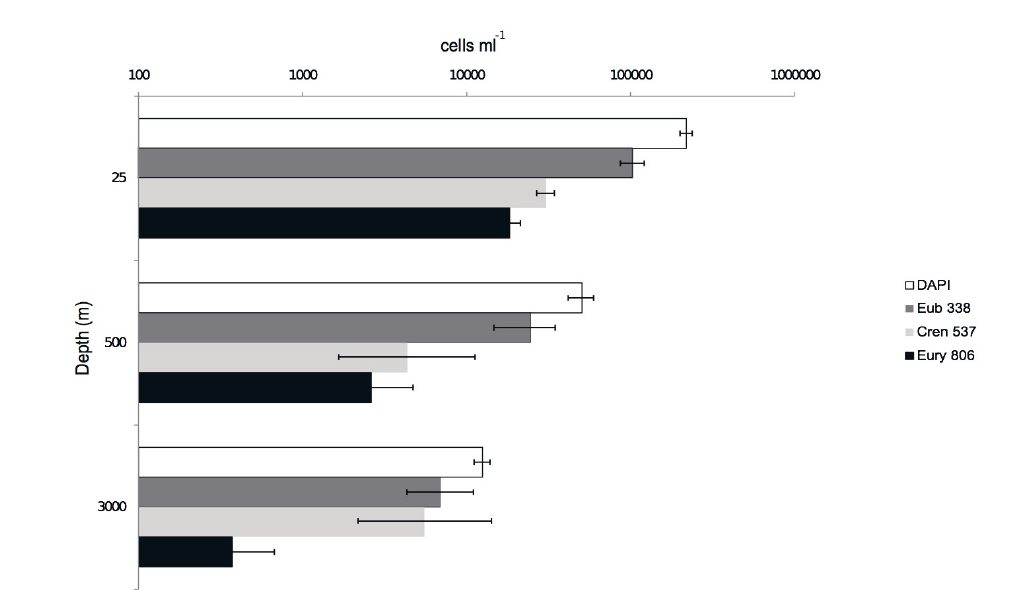
Figure 1. Distribution of total amount of prokaryotic cells counted as DAPI-stained cells (in white), CARD-FISH-positive Bacteria (in dark grey), Crenarchaea (in light grey) and Euryarchaea (in black) at the Station Vector site in December 2013, for 25 m (Modified Atlantic Water (MAW)), 500 m (Levantine Intermediate Water (LIW)) 3000 m (Tyrrhenian Deep Water